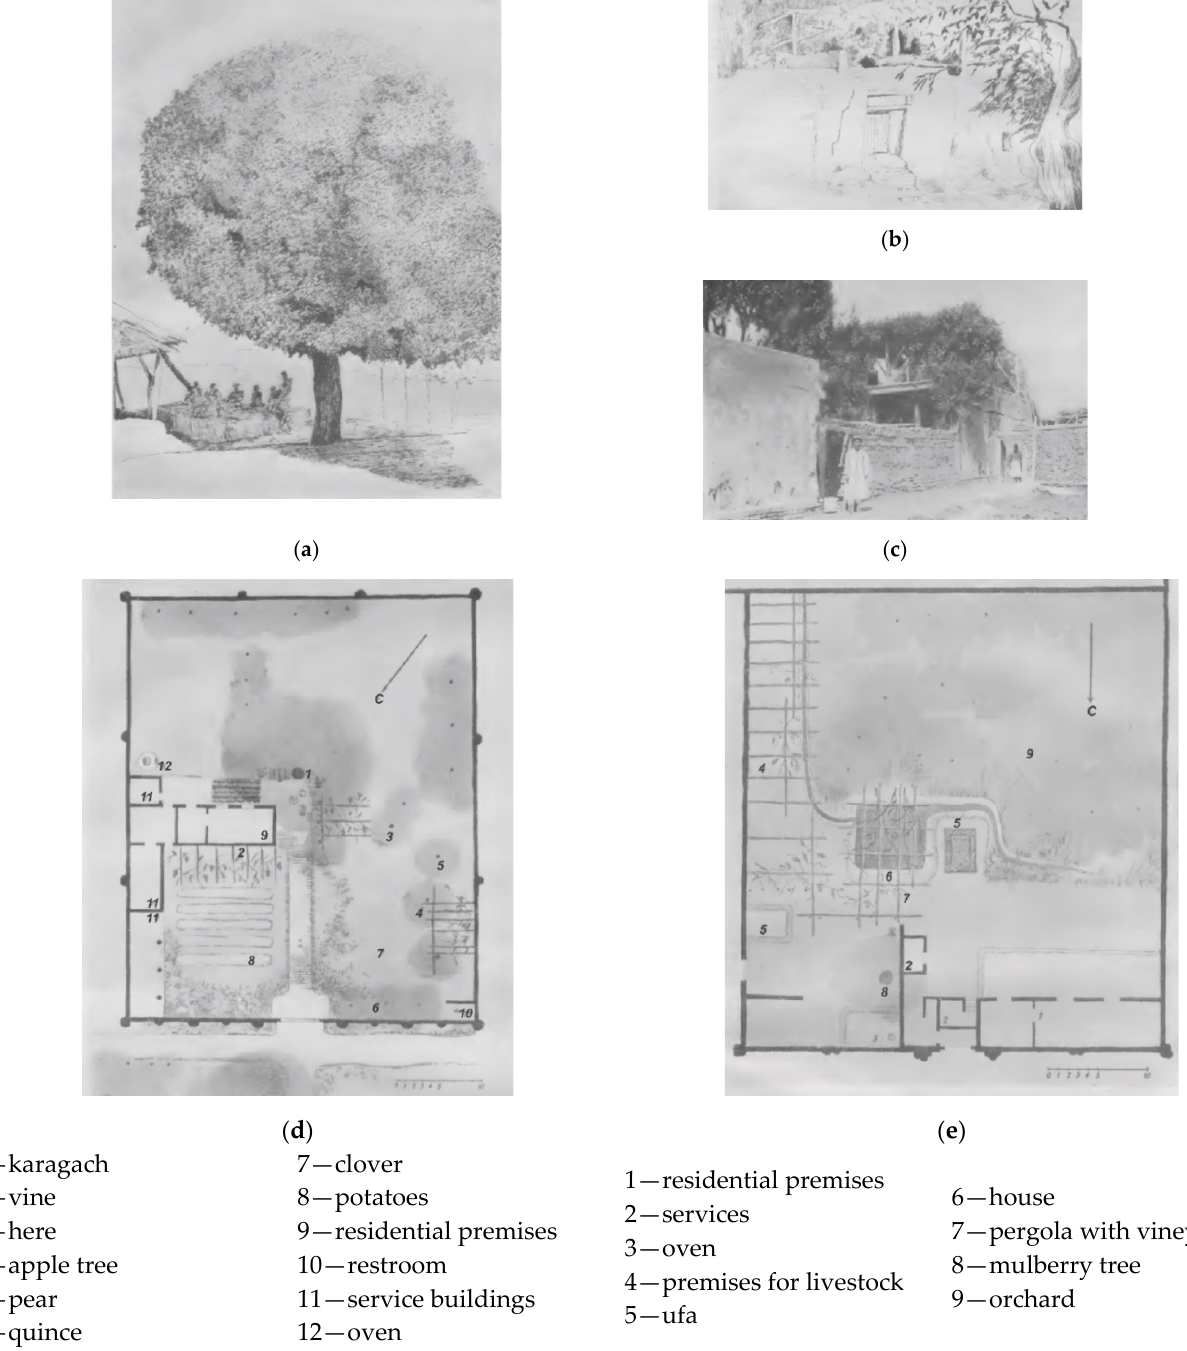
Figure 3. Traditional folk dwelling in Central Asia (according to Zelenskaya L.S.): ( a ) elm tree, ( b ) vineyard on the 2nd floor of a house (Kokand city), ( c ) vineyard on the 2nd floor of a house (Samarkand city), ( d ) Nuridinov Nabi house plan (Samarkand, Penjikentskaya St.), ( e ) plan of a country house on Khiva St., Samarkand. (https://docviewer.yandex.kz (accessed on 8 July 2021)).